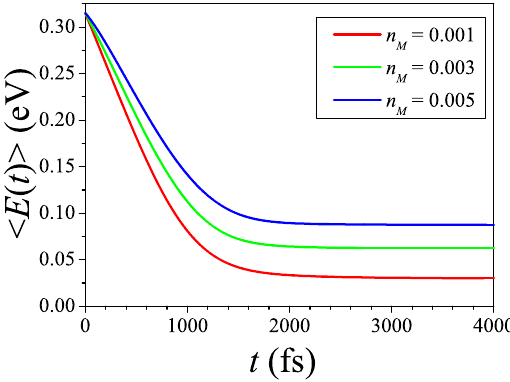
Figure 7. n M -dependence of the mean energy is